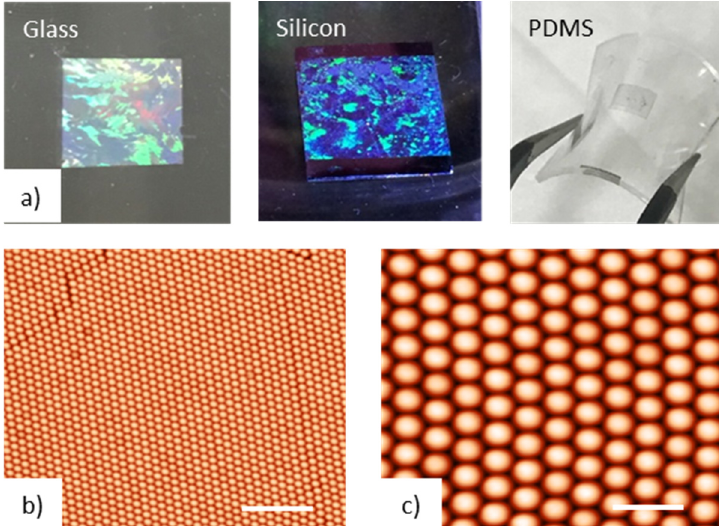
Figure 1. ( a ) Example of a colloidal mask deposited onto a solid substrate like glass and silicon or onto a flexible substrate like polydimethylsiloxane (PDMS); ( b ) atomic force microscopy (AFM) images at low ( b ) and high ( c ) magnification of a close packed array (CPA) of polystyrene (PS) particles with diameter of 500 nm; The scale bars are 4 and 1 µ m, respectively.